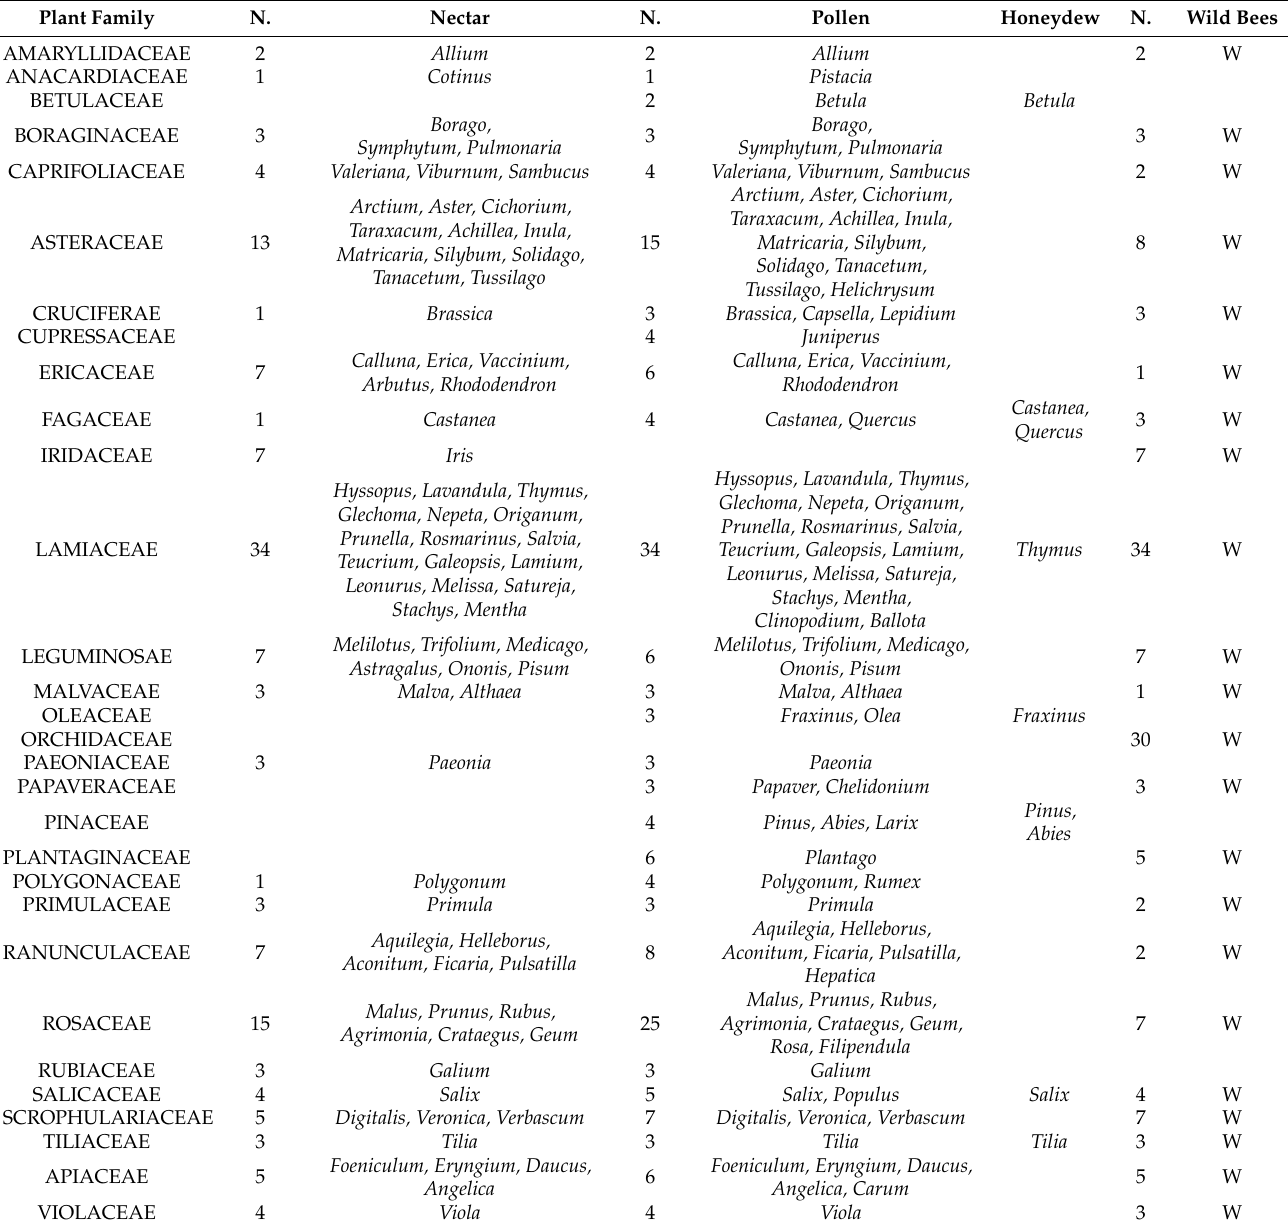
Table 2. Main plant taxon (family, genus) of the European medicinal plant red list in relation to bee foraging sources. N = number of species belonging to the shown genus or group (W = attractive plants for wild bees). Plant data from Allen et al. [68], bee preferences for pollen and nectar from MLR, [73], MAA, [74]. Plant Family